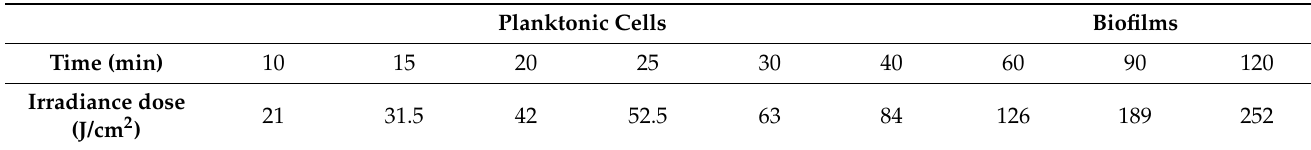
Table 1. Irradiance doses at 402 nm and 440 nm used in